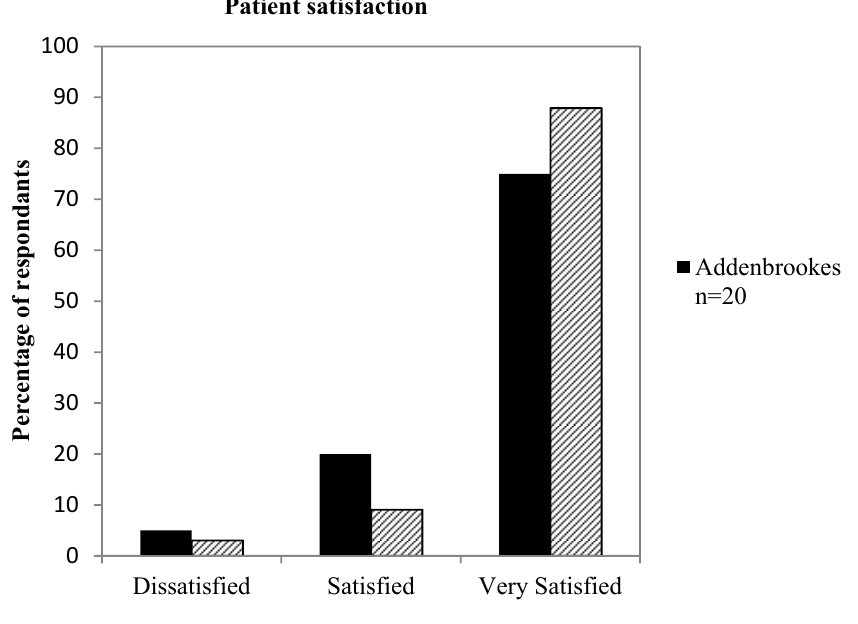
Figure 3. Bar graph displaying the percentage of topics patients would like to discuss (hashed bars) contrasted to the areas actually discussed during the appointment. Data contains answers from all patients both at AH and